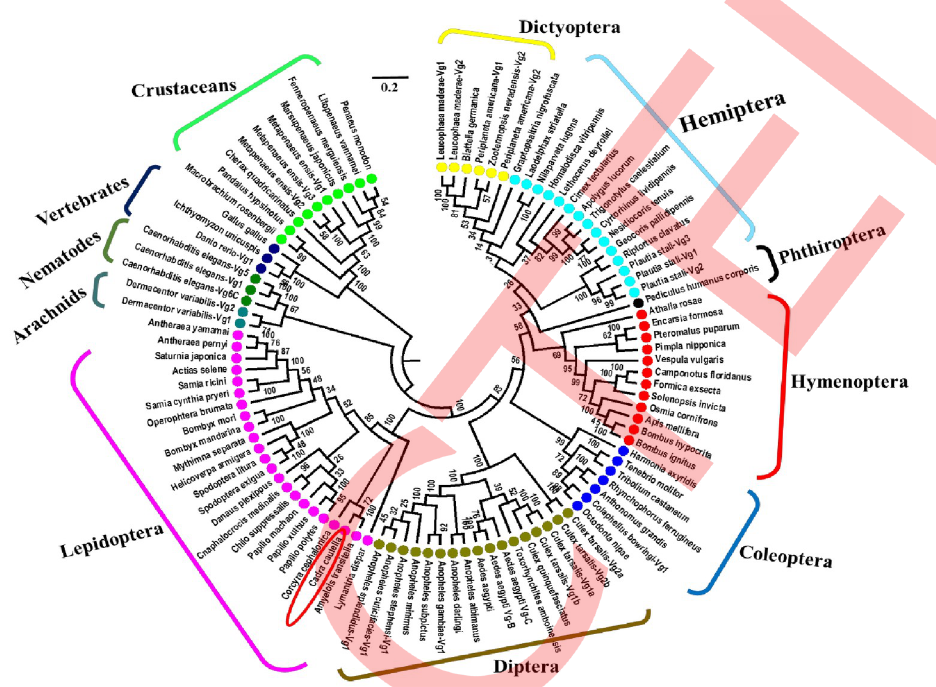
Fig 3. Neighbor-joining phylogenetic tree of different insect Vgs representing seven insect orders. The Clustal W and MEGA 6, a neighbor-joining tree construction program, were used. A scale of 0.2 indicate the distance (a number of amino acid substitutions per site). Species belonging to different orders are marked with different colors.